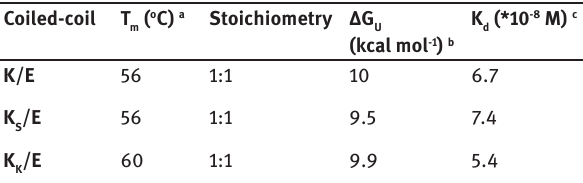
Table 4: Binding constants of coiled coils from CD spectroscopy. Coiled-coil T ( o C) a Stoichiometry ΔG m